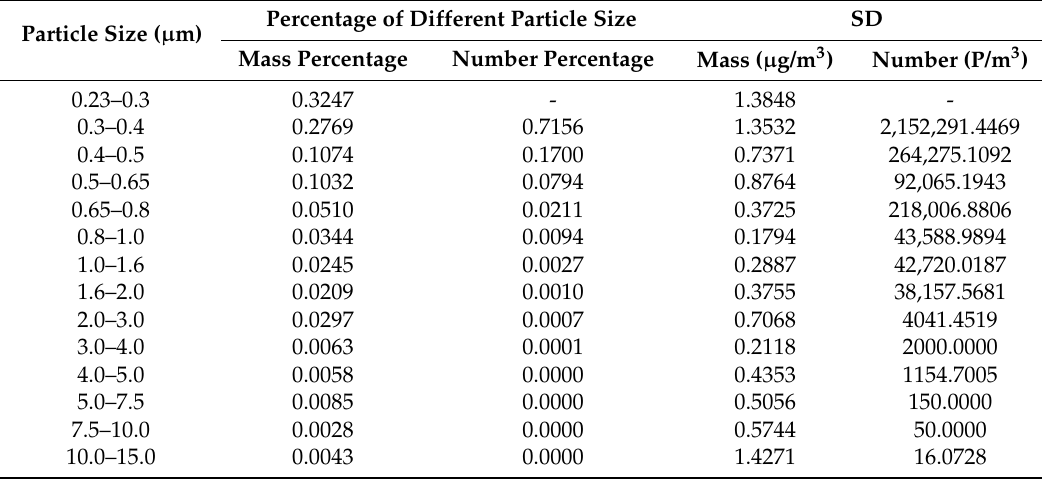
Table 4. Mass and count percentage of different particle sizes in pure wax candle